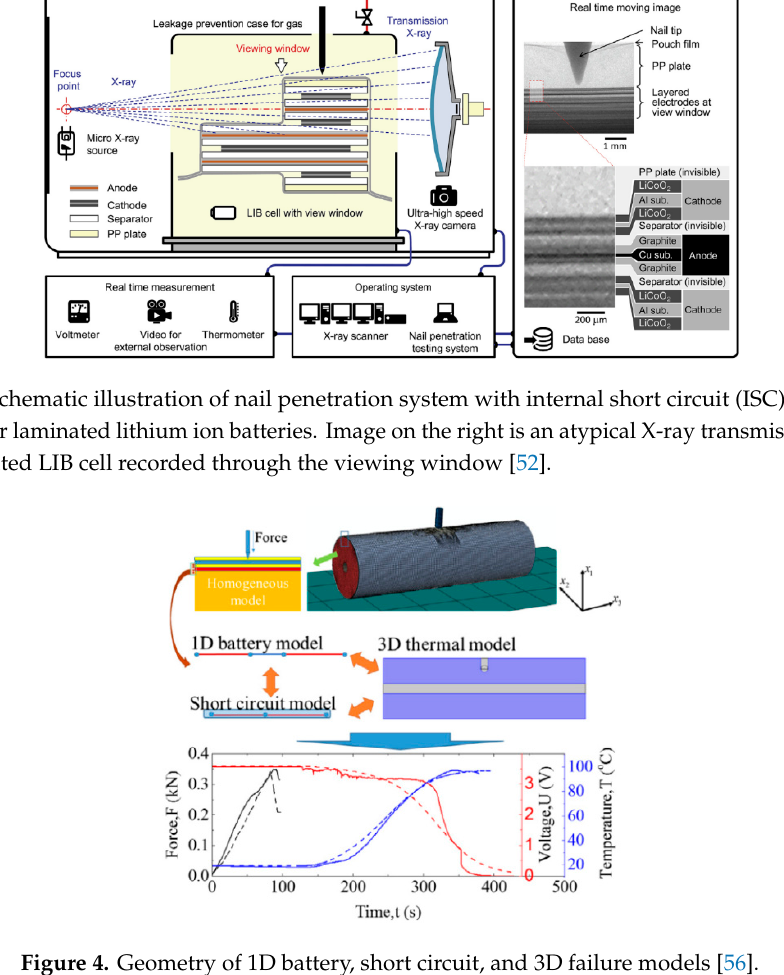
Figure 4. Geometry of 1D battery, short circuit, and 3D failure models